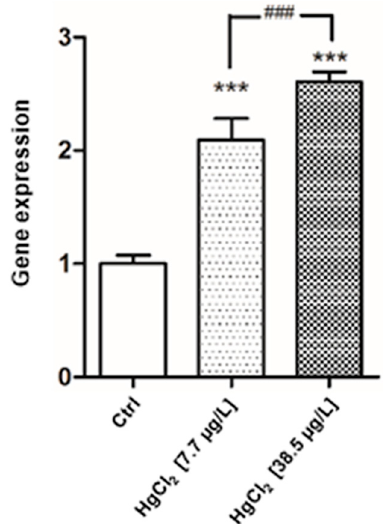
Figure 9. Relative variations in mt Gene Expression As Compared to control in Danio rerio liver after 96 h of exposure to HgCl 2 (7.7–38.5 μ g/L). Taqman real time relative quantitative PCR. The bars show mean ± S.D, n = 5. Asterisks indicate the treated groups that differ from the control, *** p < 0.001; hashtags indicate difference between treated groups ### p < 0.001 (One way ANOVA followed by Bonferroni’s post hoc test).